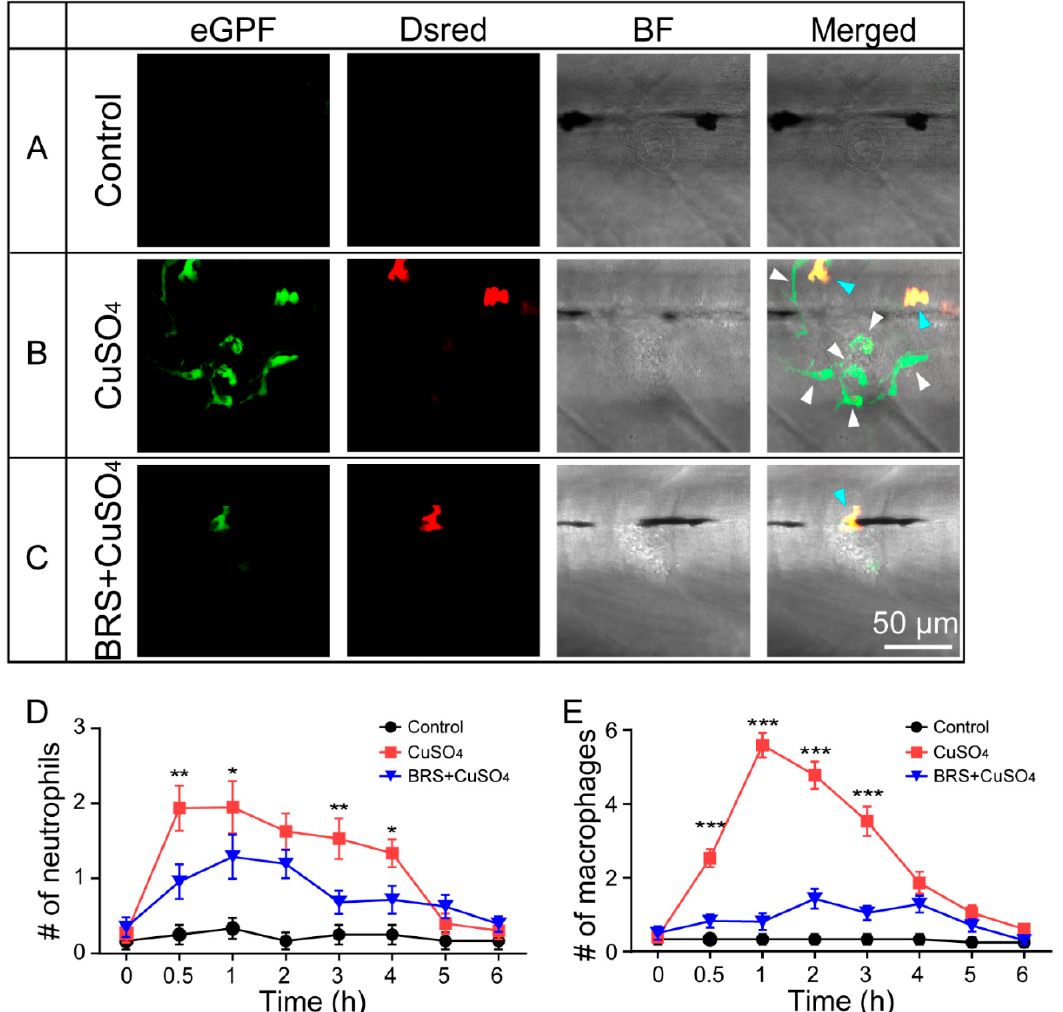
Figure 2. BRS-28 reduces the number of neutrophils and macrophages migrating to the injured neuromasts. ( A – C ) Live imaging (40×) displays the regions of L3 neuromasts of larvae at the GFP channel, Dsred channel, and bright field (BF) channel and a superimposed image in different groups. Neutrophils (showing both green and yellow fluorescence, indicated by blue arrows) and macrophages (showing only green fluorescence, indicated by white arrows) around the neuromasts could be observed in Tg(coro1a:eGFP; lyz:Dsred2) larvae. They were almost entirely absent from the neuromasts in the control group ( A ). Many neutrophils and macrophages migrated to injured neuromasts in the CuSO 4 group ( B ), while fewer neutrophils and macrophages migrated to injured neuromasts in the BRS+CuSO 4 group ( C ). The image was captured after adding CuSO 4 solution for 1 h. Scale bar represents 50 µ m. ( D , E ) Line charts reveal decreased numbers of neutrophils ( D ) and macrophages ( E ) within a radius of 50 µ m from the center of neuromasts at di ff erent time points after adding CuSO 4 in the BRS + CuSO 4 group (16 ≤ n ≤ 23) compared to the CuSO 4 group (15 ≤ n ≤ 23). The control group (11 ≤ n ≤ 12) was observed at the same time points. The y -axis is a mean of multiple neuromasts (L2, LII3, and L3 neuromasts) from multiple zebrafish. The n values represent the numbers of neuromasts. In ( D , E ), the asterisk shows the di ff erence between the CuSO 4 group and the BRS + CuSO 4 group. Comparisons were performed using two-way ANOVA, with Tukey’s multiple comparisons test. All error bars show mean ± S.E.M., *** p < 0.001, ** p < 0.01, * p < 0.05.